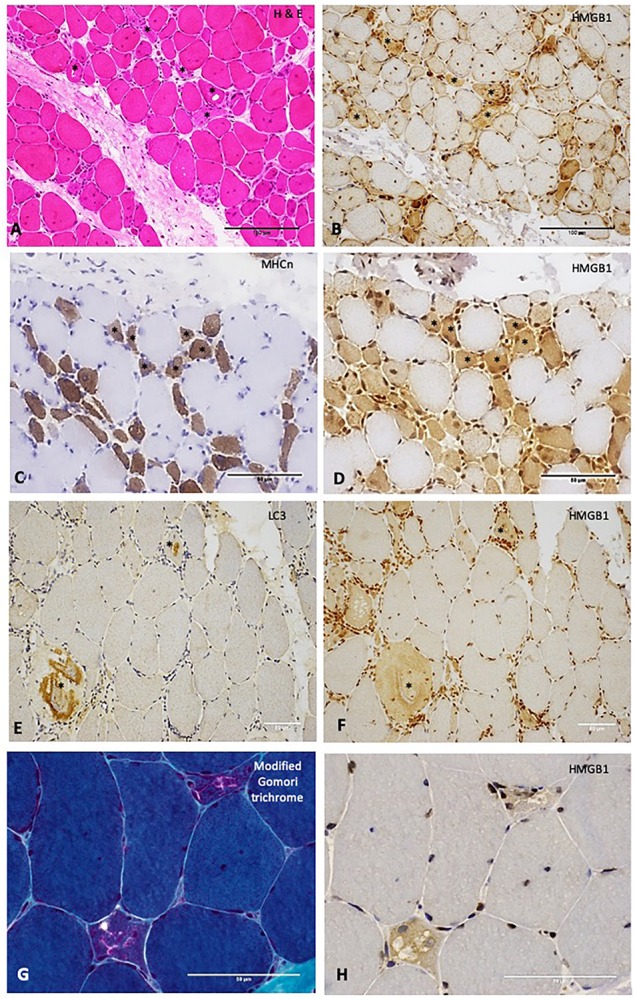
Relationships between High Mobility Group Box Protein 1 (HMGB1) and other histopathological processes in the muscle. (A) H&E stain of muscle from a patient with IMNM demonstrating scattered necrotic fibers (examples *). These fibers stain positively for HMGB1 (B). Scale bars 100 microns. (C) Neonatal myosin heavy chain (MHCn) staining of a section obtained from a patient with IMNM demonstrating numerous regenerating fibers (examples *). These fibers exhibit strong HMGB1 staining (D). Scale bars 50 microns. (E) LC3 staining of muscle from a patient with IBM showing abnormal positivity in two cells (*). These cells were positive for HMGB1 (F). (G) Modified Gomori trichrome stain of a patient with IBM demonstrating two cells with abnormal cytoplasmic protein inclusions and vacuolar change. These cells were HMGB1 positive (H). Scale bars 50 microns. Magnification: (A,B) x200; (C–F) x400; (G,H) x 600. HMGB1, high mobility group box protein 1; IMNM, immune-mediated necrotising myopathy; LC3, Microtubule-associated protein 1A/1B-light chain 3.